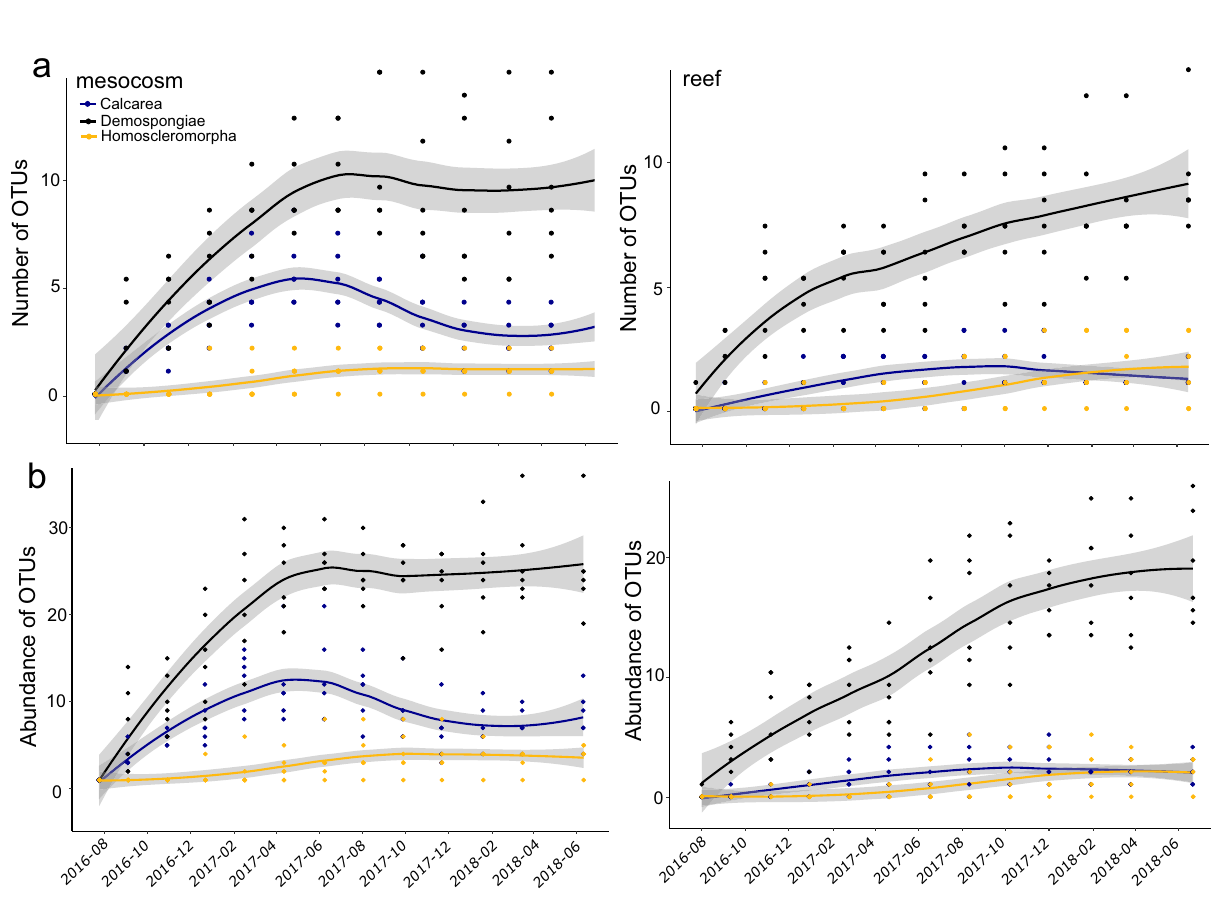
Figure 4. Temporal recruitment of ( a ) sponge OTUs and ( b ) abundance of OTUs settling on mesocosm (left panel) and reef ARMS (right panel). OTUs are presented by sponge classes Calcarea (in purple), Demospongiae (in black) and Homoscleromorpha (in yellow). Line graphs are presented with lower and upper pointwise confidence